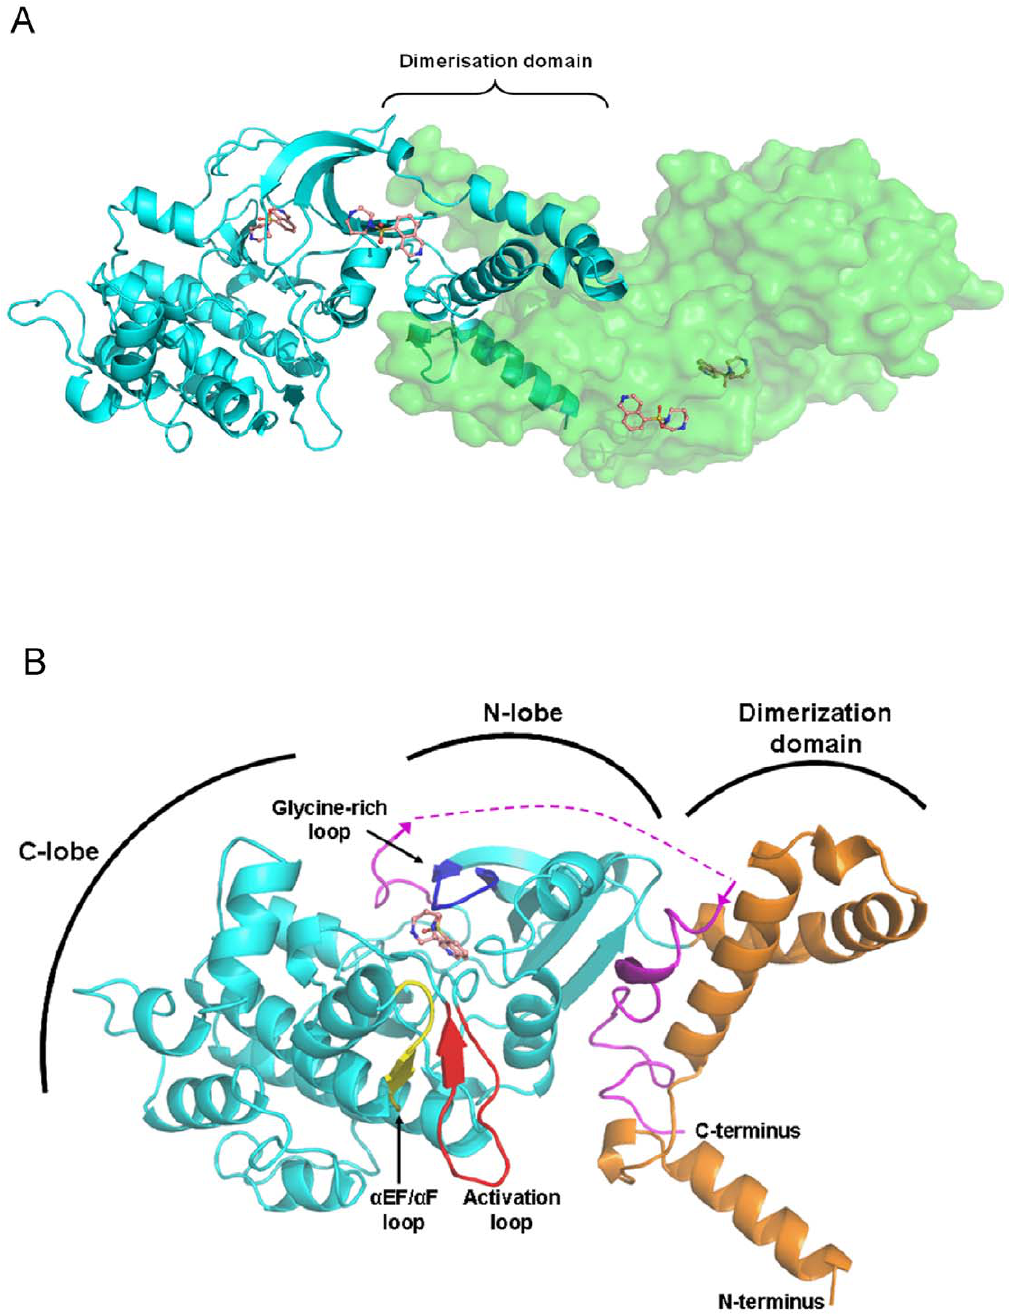
Figure 3. Structure of dimeric MRCK b . ( A ) Overall structure of the dimeric MRCK b shows the interactions of the two monomers at the dimerization domain. The four Fasudil molecules observed per asymmetric unit are also shown, two bound to the surface of the protein (central) and one bound to each of the ATP-binding sites (lateral). ( B ) A close-up of one monomer reveals a typical two-lobed kinase structure, with both the N- terminus (orange) and the C-terminus (purple; disorganized loop shown as a dashed line) forming the dimerization domain. The glycine-rich loop (blue) and activation loop (red) are fully ordered, and the a EF/ a F-loop is also indicated (yellow). Fasudil is shown bound in the ATP-binding site.